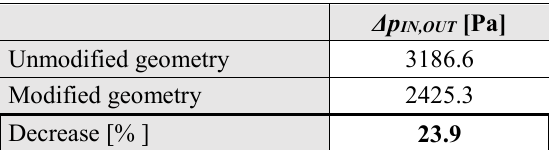
Fig. 10. Velocity Vectors Colored by Velocity Magnitude v / m/s: modified geometry